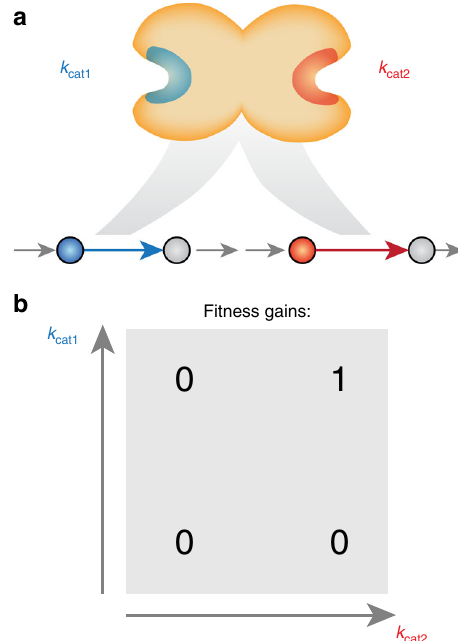
Fig. 3 Multifunctional enzymes cause synergistic epistasis in k cat evolution. a A multifunctional enzyme with two distinct active sites catalyzes two reactions in the same linear fi tness-relevant pathway. b Mutations that increase either k cat individually cannot be used to reduce protein cost of the pathway and thus exhibit synergistic epistasis